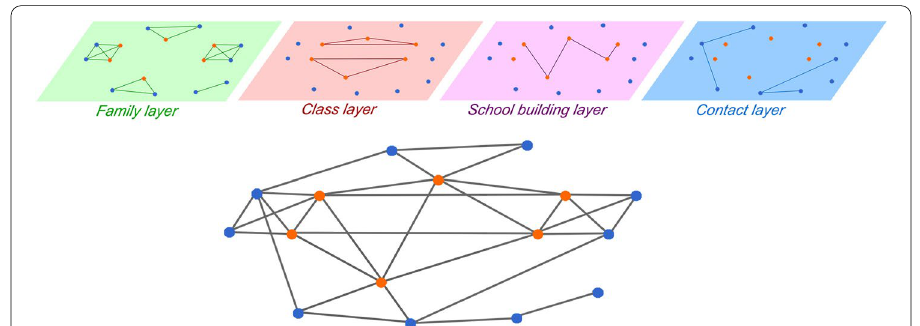
Fig. 2 Schematic of the four-layered network structure with a sample realization of the four distinct layers in a time-step t (top), and of the corresponding aggregate network of interactions (bottom). Orange nodes represent children (which are partitioned into two classes in the same building), blue nodes represent